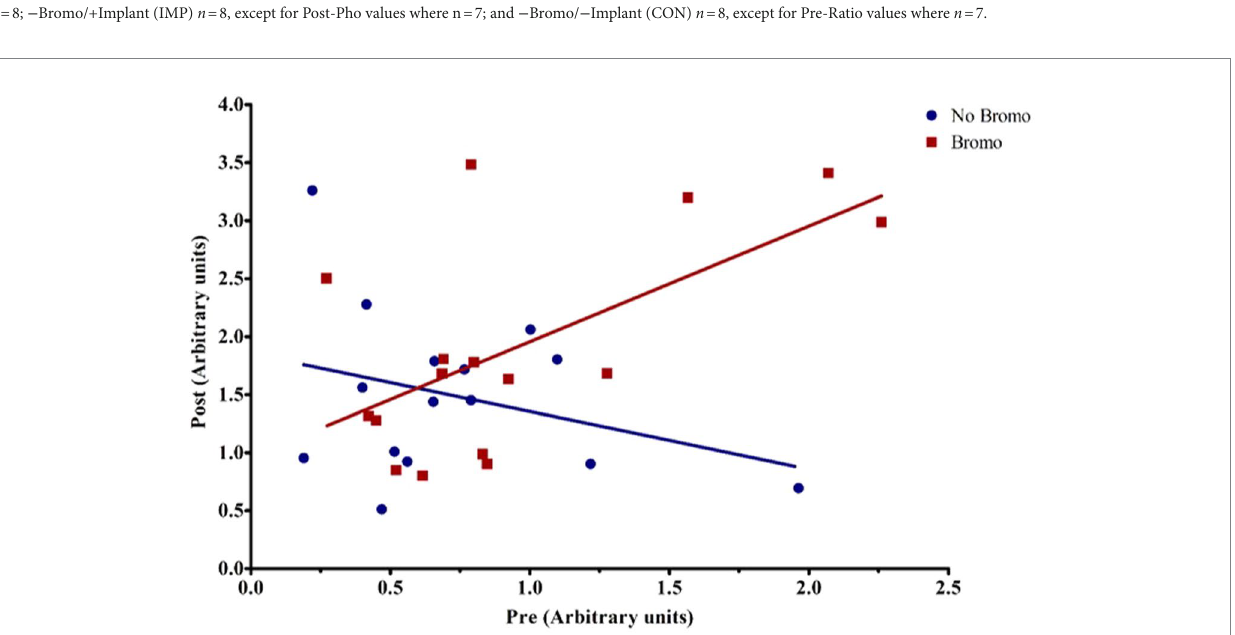
TABLE 6 Relative abundance in arbitrary units of activated, phosphorylated, and total mTOR proteins in muscle of steers treated with bromocriptine and estradiol/TBA implants before (pre) and in response (post) to an IV glucose bolus. + Bromo − Bromo p -values Covariate p - + + SEM 1 Bromo Implant Bromo * Implant Pre * Bromo − − Implant Implant Implant Implant